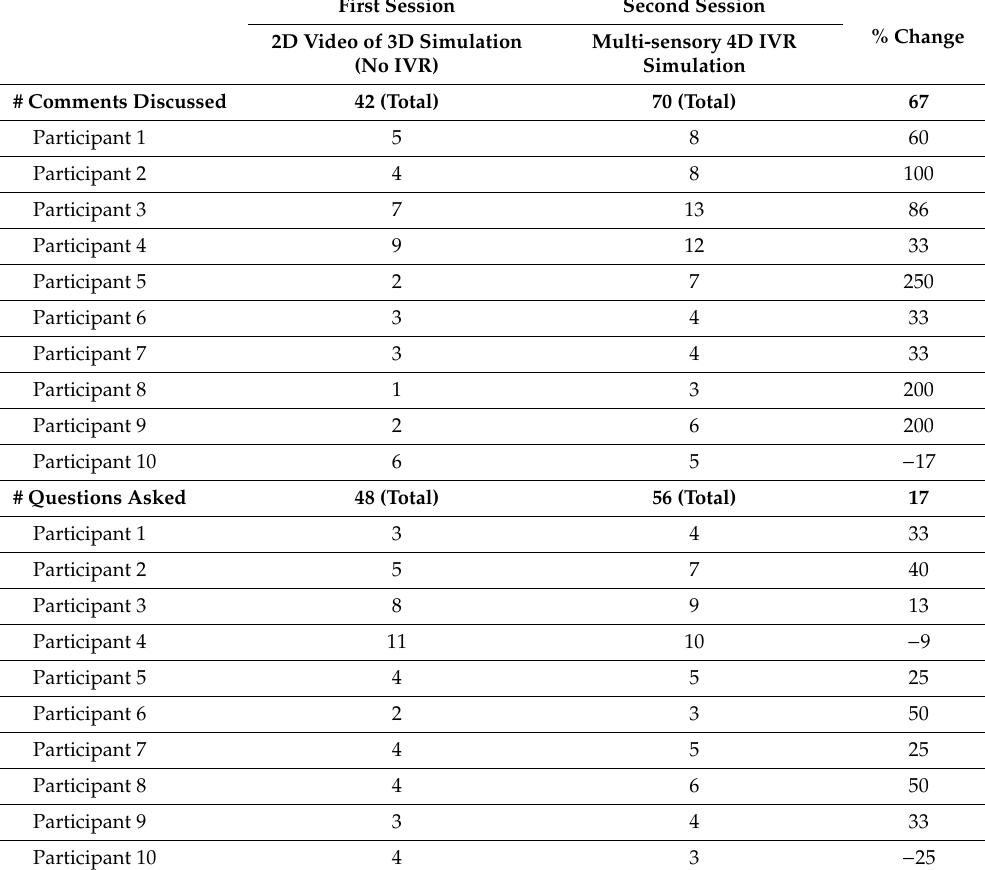
Table 2. Interaction records of comments or questions made by focus group 4